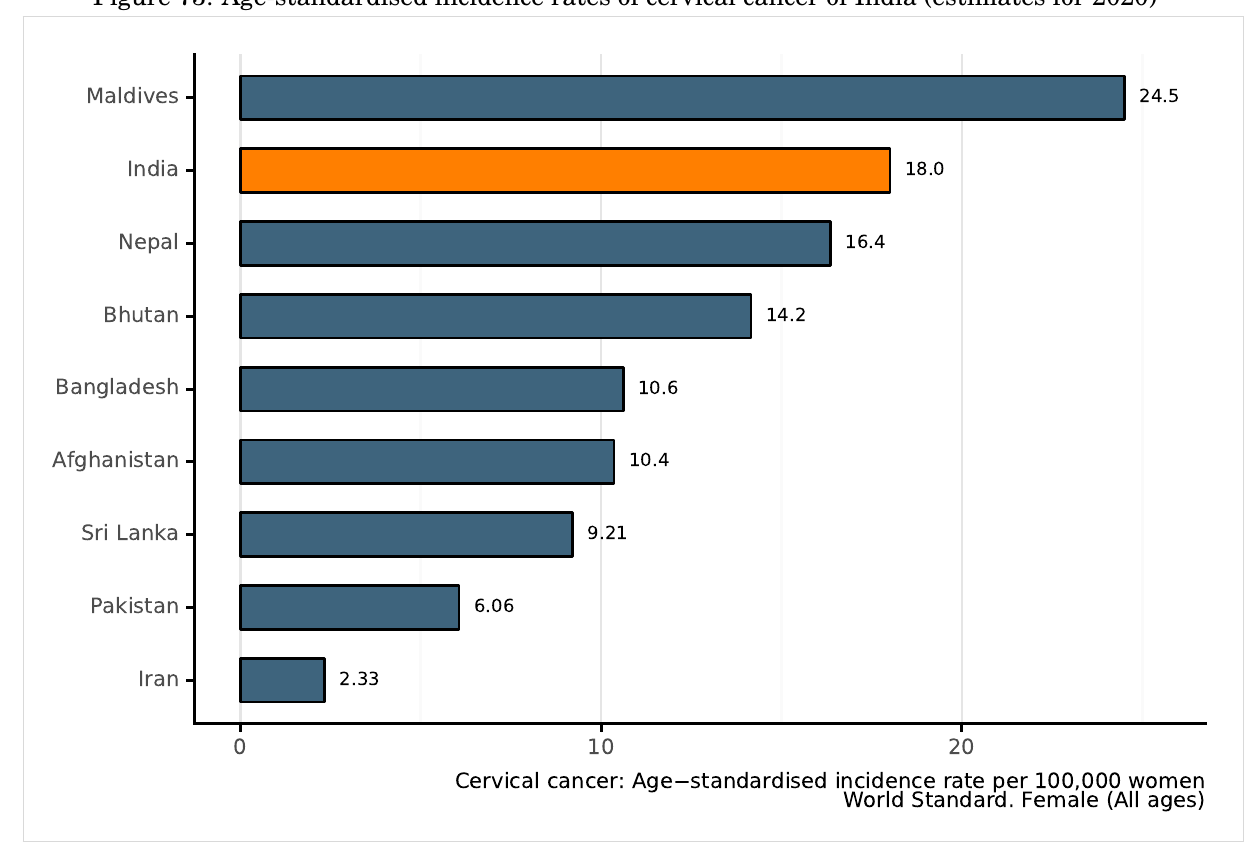
0 20 Cervical cancer: Age standardised incidence rate per 100,000 women World Standard. Female